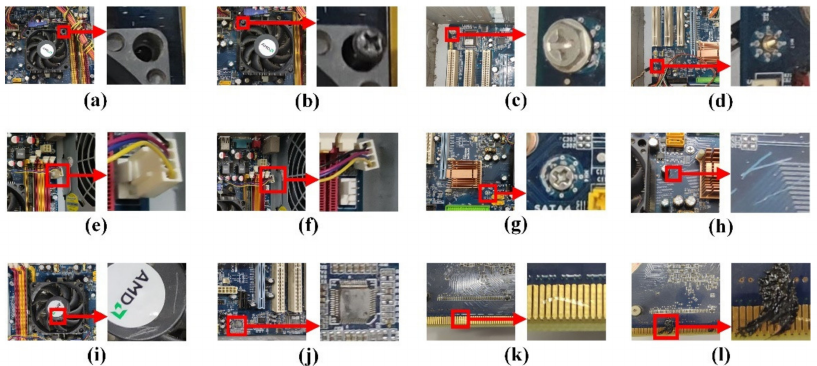
Figure 1. Examples of the 12 types of defects. ( a ) Loose fan screws. ( b ) Missing fan screws. ( c ) Loose mainboard fixing screws. ( d ) Missing mainboard fixing screws. ( e ) Missing fan wiring. ( f ) Loose fan wiring. ( g ) Wrong type of screws. ( h ) mainboard scratches. ( i ) fan scratches. ( j ) chip polishing. ( k ) Interface scratches. ( l ) interface